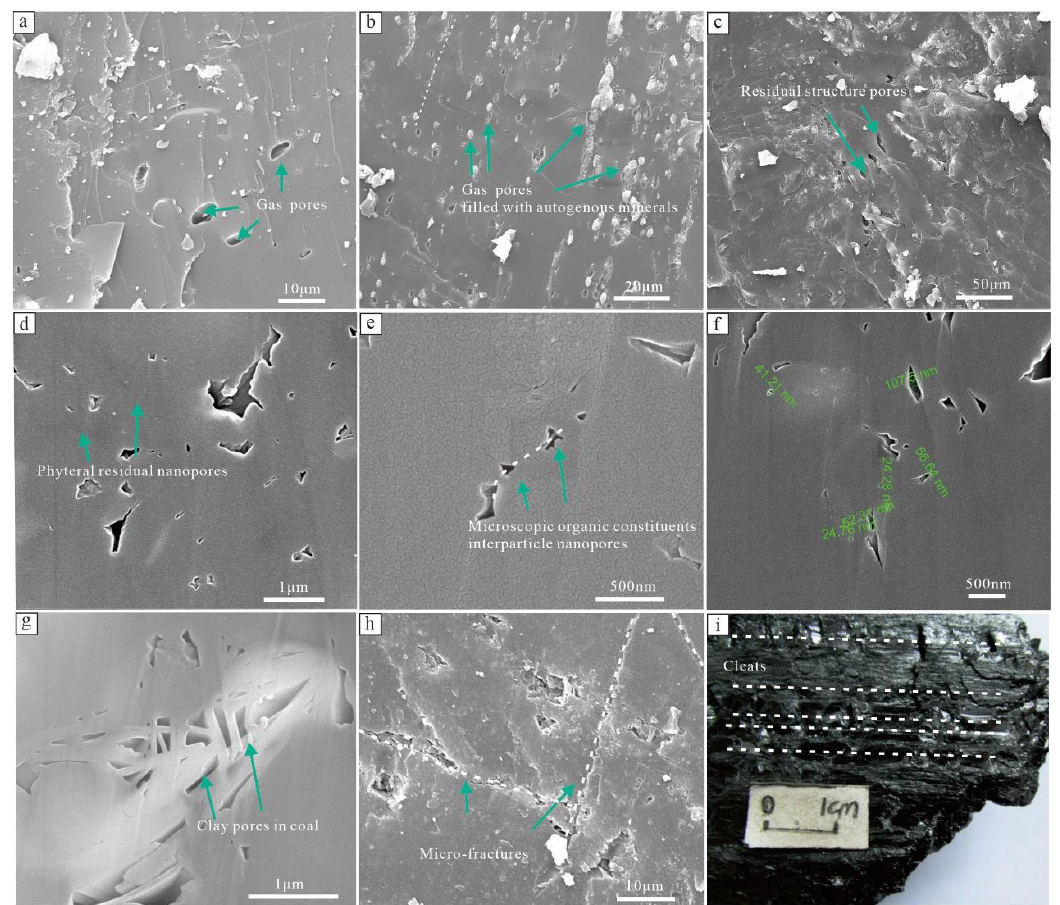
Figure 4. Microreservoir space of nano–micro pores and small-scale fractures in high-rank coal matrix. ( a ) Gas pores in microscale; ( b ) gas pores with autogenous minerals; ( c ) residual structure pores in microscale; ( d , e ) organic constituents interparticle nanopores; ( f ) pore size processing of nanopores; ( g ) mineral pores in coal; ( h ) fractures; ( i ) cleats.